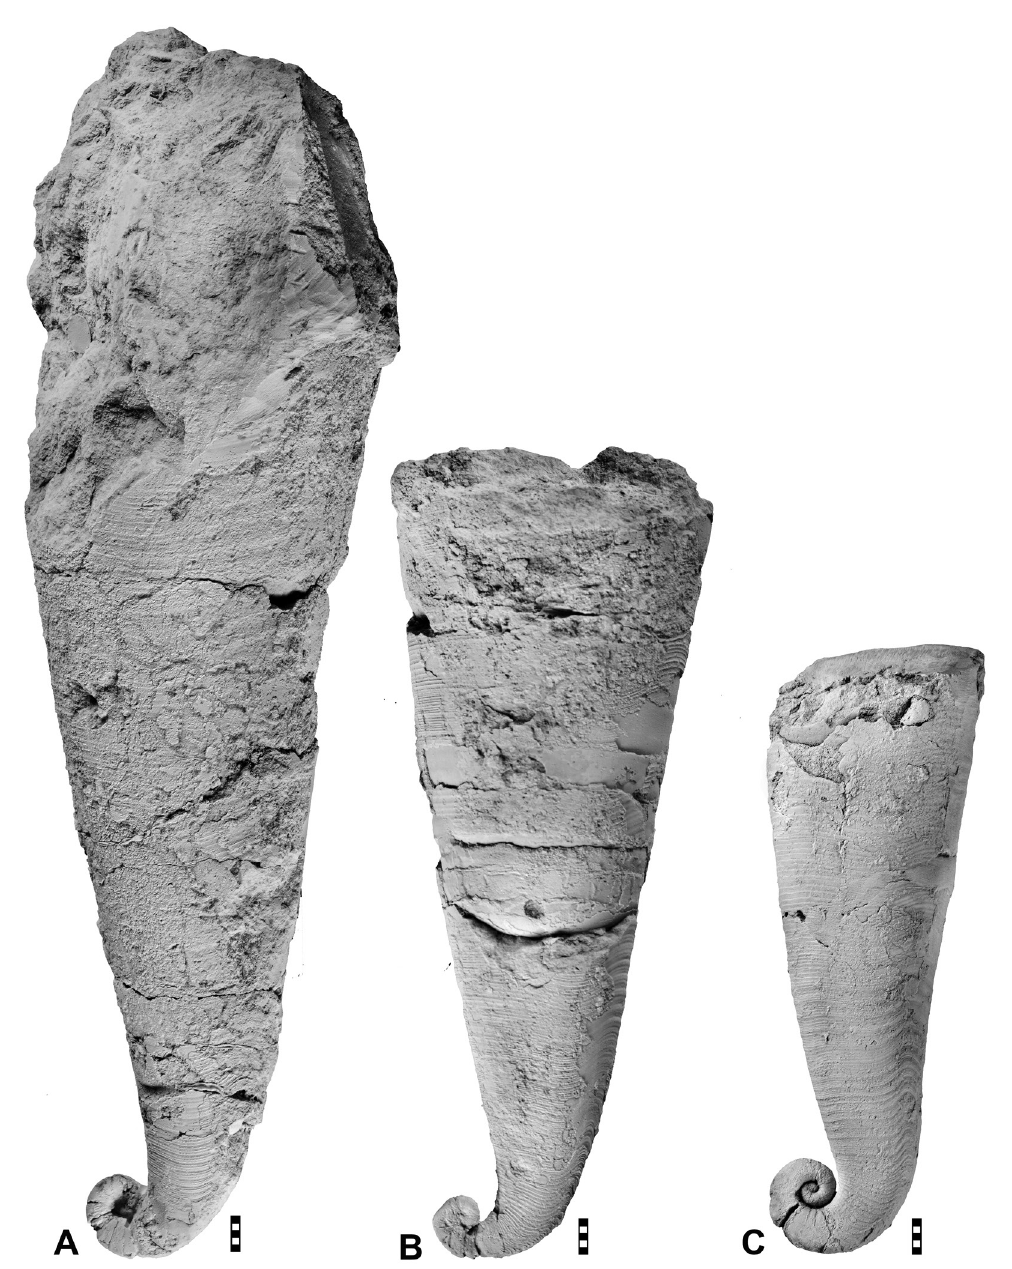
Fig. 21. Ancistroceras barrandei Dewitz, 1880 from the Upper Grey Orthoceratite Limestone. A . Specimen MB.C.30518 (Neben & Krueger Coll.) from Rerik (Ostsee); previously figured by Neben & Krueger (1971: pl. 17 fig. 1). B . Specimen MB.C.30516 (Neben & Krueger Coll.) from Rerik (Ostsee). C . Specimen MB.C.11991 (Helms 1966 Coll.) from Groß Zicker (Island of Rügen). Scale bar units = 1